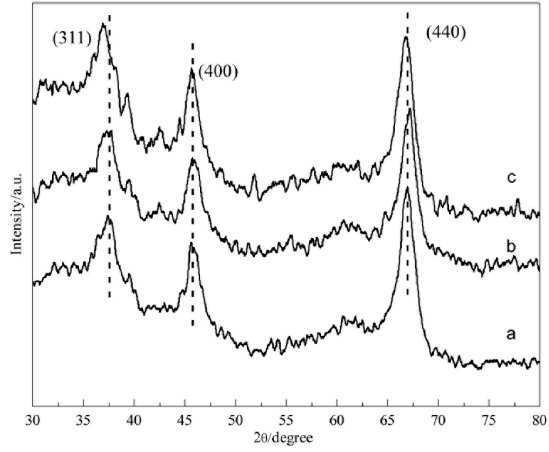
Figure 2. X-ray diffraction patterns of ( a ) γ -Al 2 O 3 ; ( b ) Fe/ γ -Al 2 O 3 ; ( c ) Fe-Co/ γ -Al 2 O 3 .